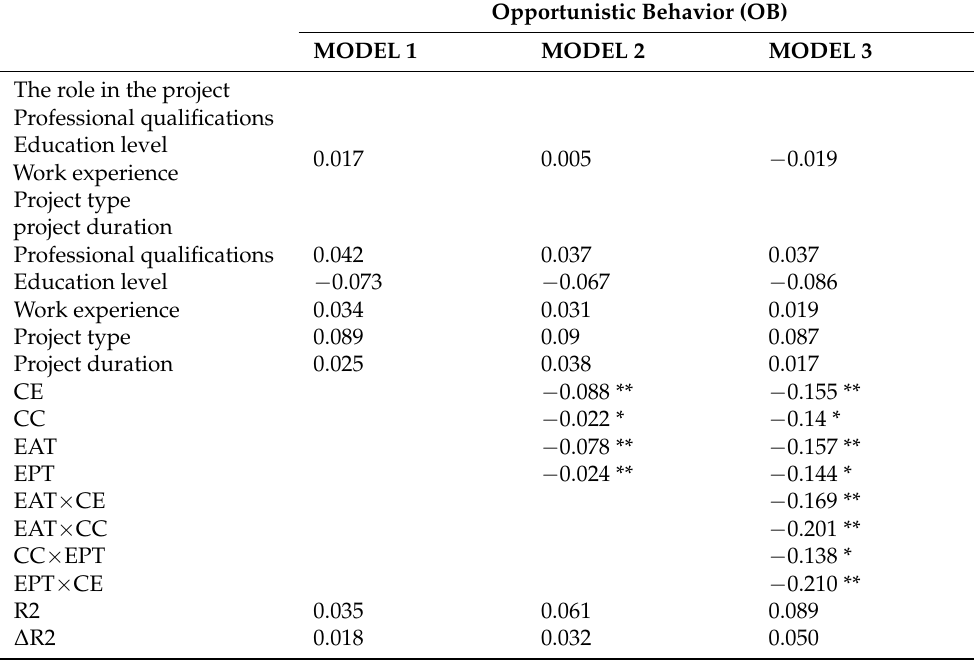
Table 4. Standardized Coefficient Estimates of